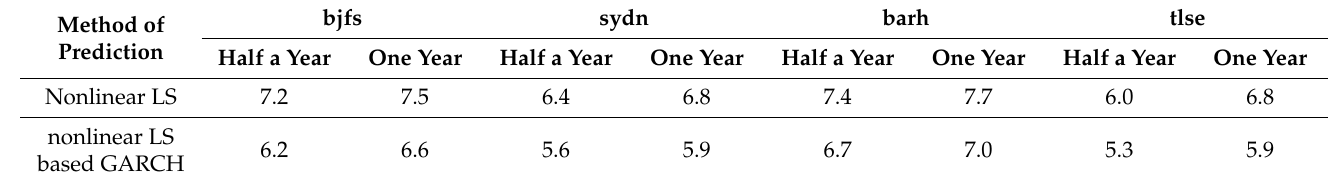
Figure 14. Prediction of four CORS station elevations based on GARCH nonlinear velocity field. Table 10. Comparison of RMSE accuracy of elevation modeling predictions of four CORS stations (mm).